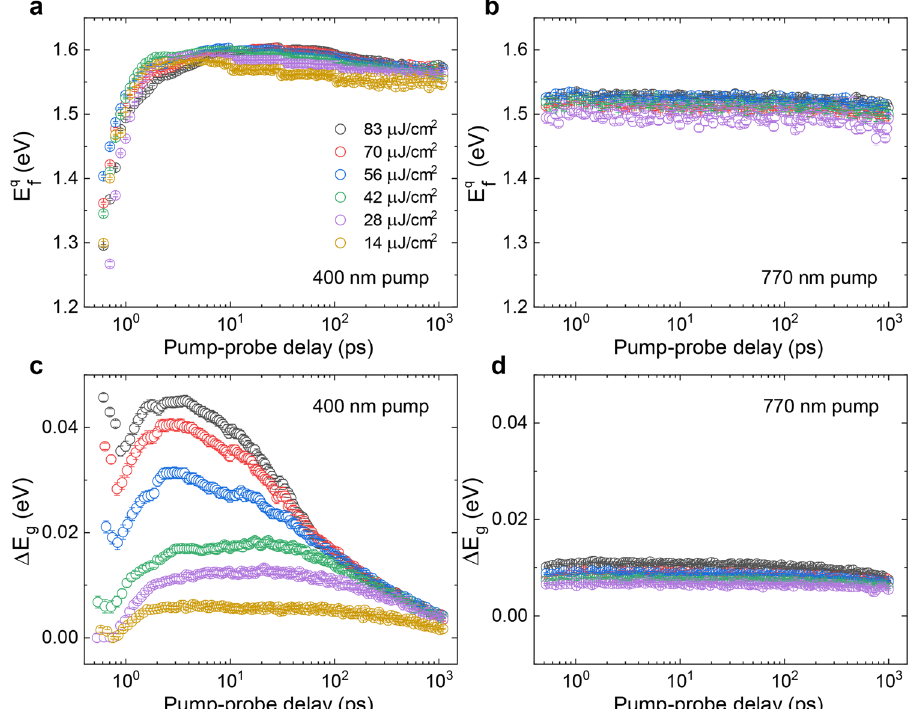
( a , b ) and bandgap Δ E g ( c , d ). Δ E g is de fi ned as the energy f